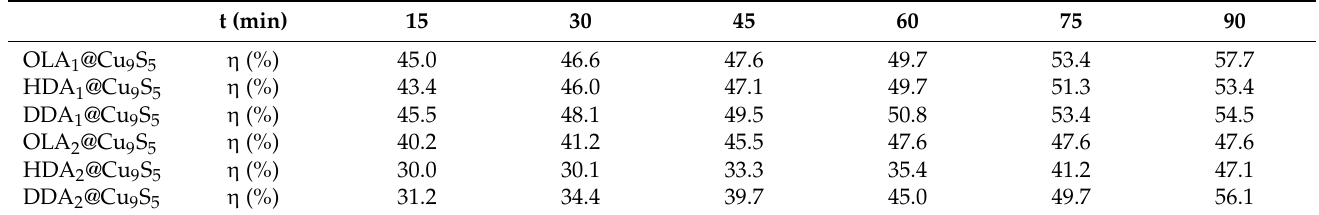
Table 4. Degradation efficiencies of OLA@Cu 9 S 5 , HDA@Cu 9 S 5 , and DDA@Cu 9 S 5 NPs obtained at 230 ◦ C using complexes 1 and